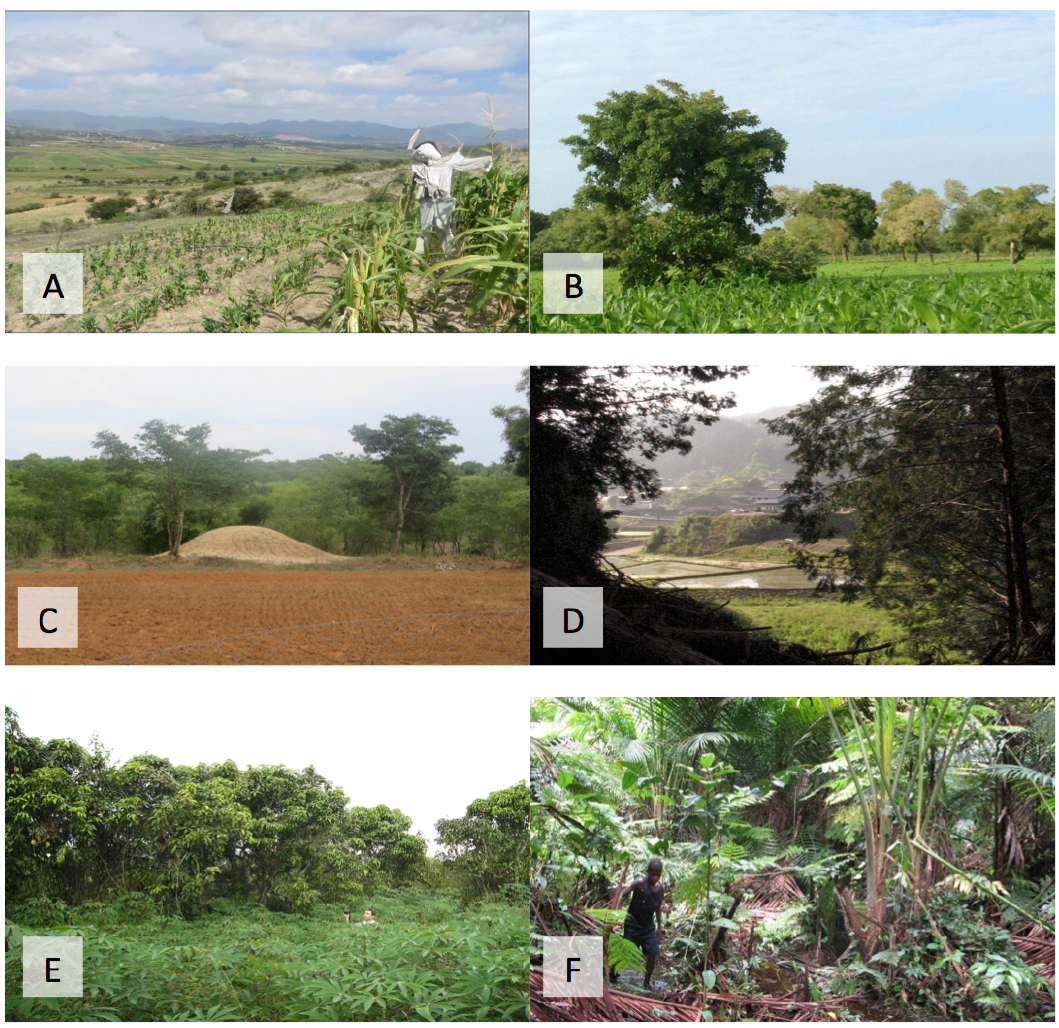
Figure 1. Examples of agricultural systems with edible insects: ( A ) Maize fields in Oaxaca, Mexico, where edible grasshoppers ( Sphenarium purpurascens ) are harvested; ( B ) Agroforestry (mixed maize Zea mays and shea Vitellaria paradoxa ) fields in western Burkina Faso, where edible caterpillars ( Cirina butyrospermi ) are harvested; ( C ) A freshly ploughed field with a termite mound in northeastern Zimbabwe, where termites ( Macrotermes spp.) are harvested; ( D ) A ‘satoyama’ (mixed paddyfield and forest) landscape in Japan, where edible wasps ( Vespula spp.), hornets ( Vespa mandarinia japonica ) and grasshoppers ( Oxya spp.) are harvested; ( E ) A mango and papaya plantation in Thailand where weaver ants ( Oecophylla smaragdina ) are harvested; ( F ) A palm plantation in Papua New Guinea where palm weevil larvae ( Rhynchophorus spp.) are harvested. ( Photos A–D by Charlotte Payne, photo E by Joost Van Itterbeeck, photo F by Kenichi Nonaka ).